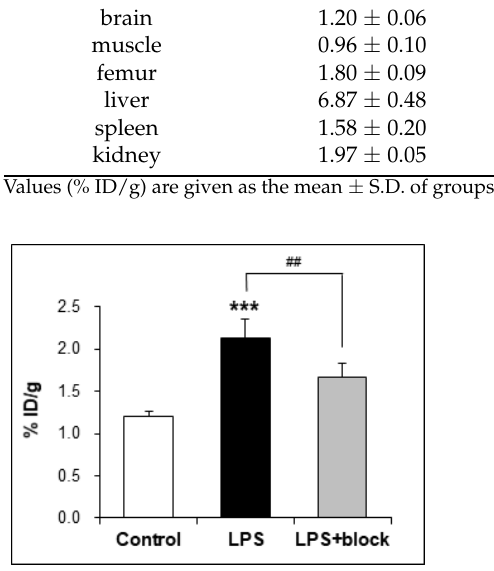
Figure 5. Ex vivo biodistribution result obtained 45 min after i.v. injection of [ 18 F] 1 into mice: brain uptakes of control mice (white), LPS mice (black), and LPS mice pretreated with CPPC (LPS+block) (grey). Data are expressed as mean % ID/g ± S.D. (n = 4). *** p < 0.001 vs. control. ## p < 0.01 vs. LPS mice.